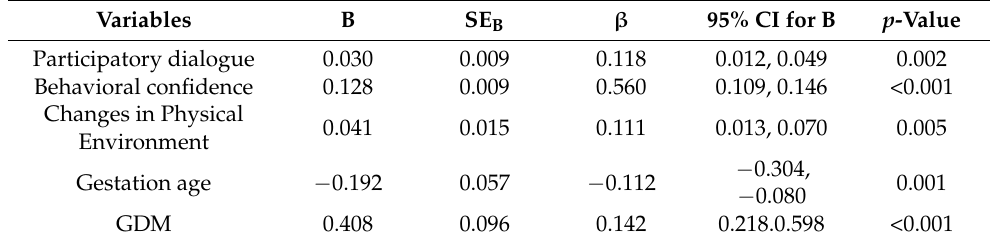
Table 5. Multiple Regression Model of intention to initiate PA Behavior ( n =